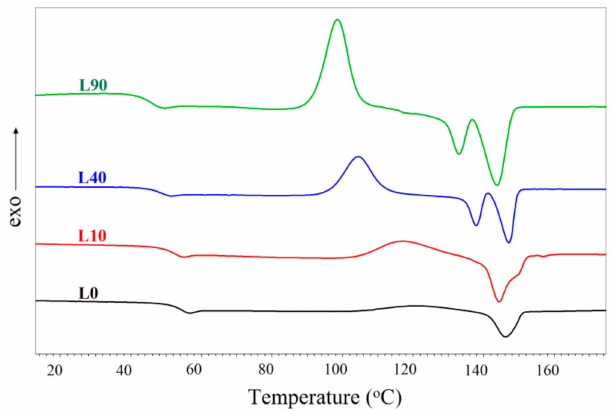
Figure 6. DSC curves recorded for the samples type L.